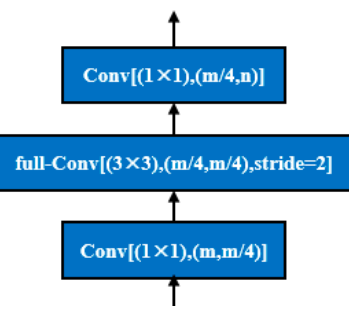
Figure 4. Structure diagram of the convolution module in the decoder.